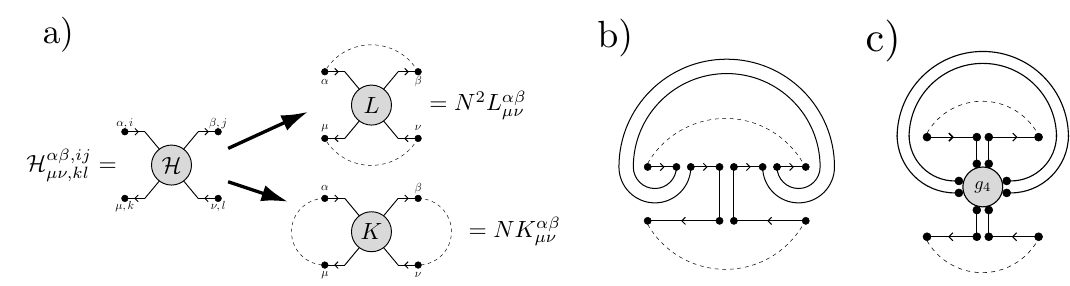
Figure 4 . a) Possible contractions of matrix indices (dashed lines) of the Kronecker product of two quaternionic resolvents. The way one contracts indices determines the class dominant planar diagrams, which are drawn between dashed lines and the horizontal baselines. The upper choice corresponds to a class of double-trace two-point functions, see (5.2), while the lower possibility leads a single-trace two point function encoding correlations of eigenvectors. Diagrams contributing to L are of wheel type [52, 53] and K is given as a sum of ladder diagrams. b) An example of a diagram which contributes to L but is subleading in the calculation of K . c) An example of a diagram appearing during the calculation of L , which despite its planarity is subleading.